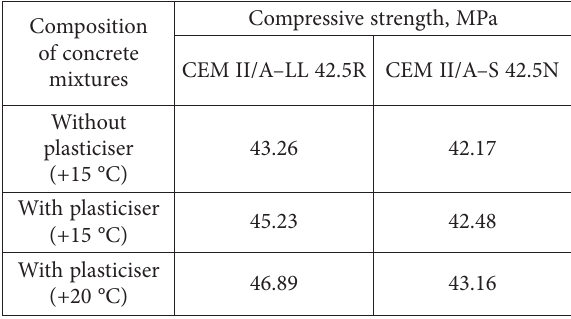
Table 9. The samples of the results of compressive strength Composition of